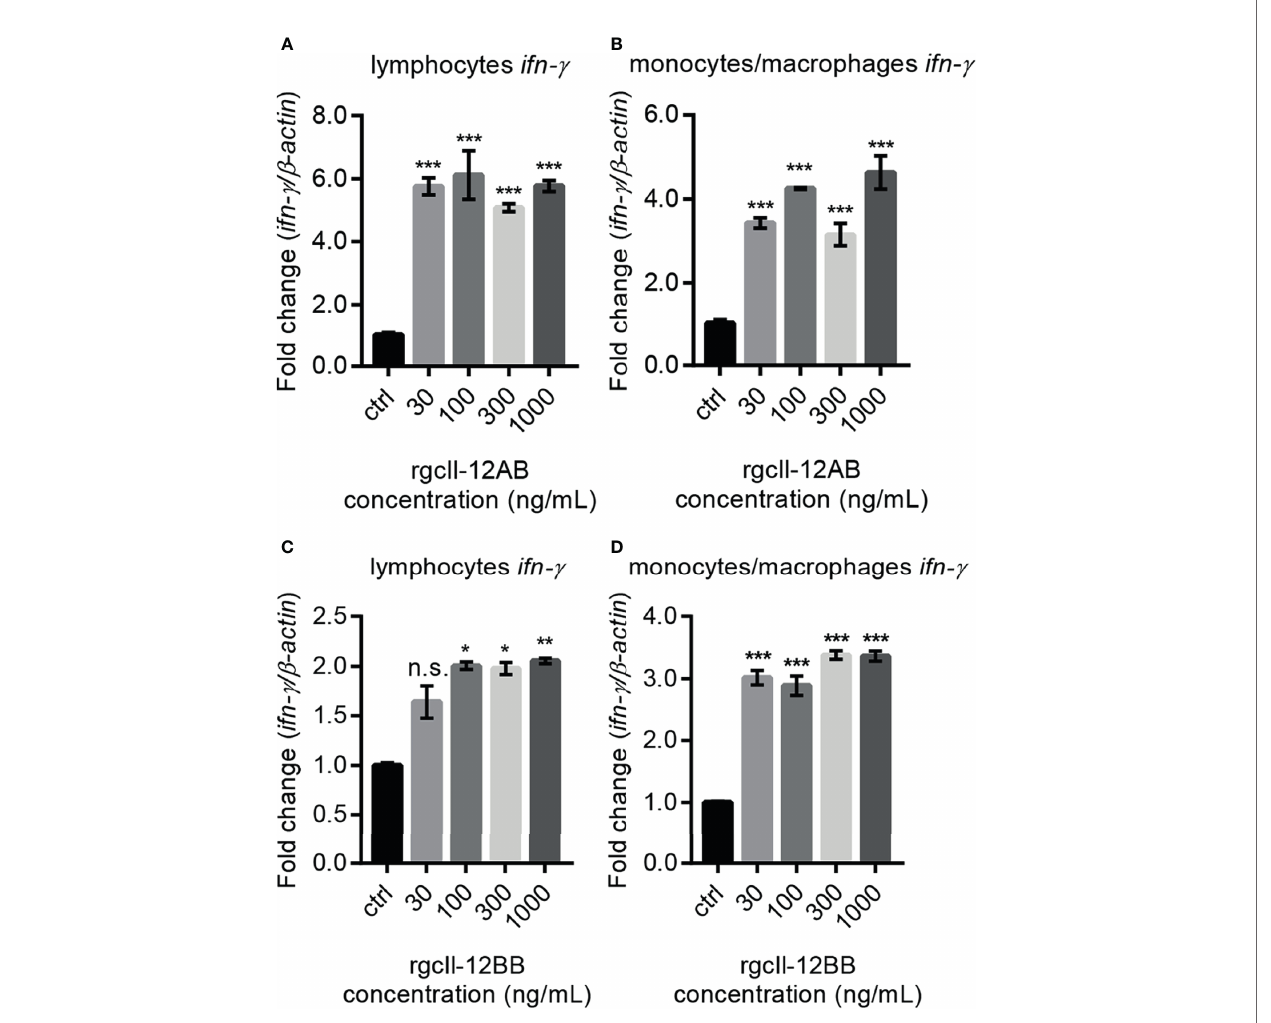
FIGURE 6 | Effects of rgcIl-12 isoforms on ifn- g mRNA expression in grass carp lymphocytes and monocytes/macrophages. Lymphocytes and monocytes/ macrophages were treated with 30-1000 ng/mL rgcIl-12AB (A, B) or rgcIl-12BB (C, D) for 12 h, respectively. The mRNA expression of ifn- g was detected by qPCR and they were normalized by b -actin and expressed as fold changes compared with the control group. Data are shown as mean ± SEM (N = 4). * p < 0.05, ** p < 0.01, and *** p < 0.001. The “ n.s. ” indicates no signi fi